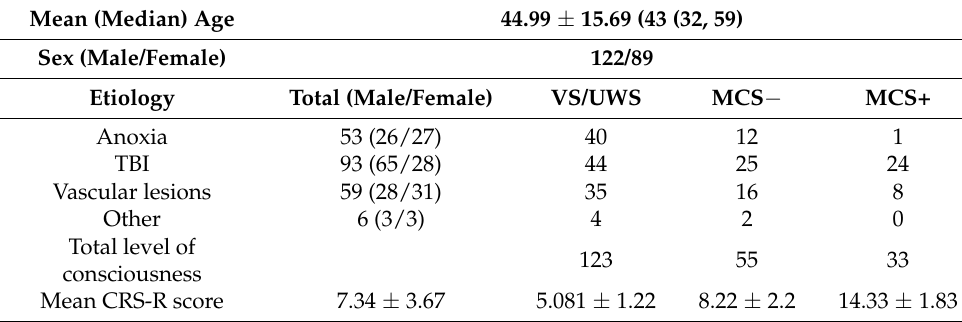
Table 2. Demographical and clinical data of patients at study